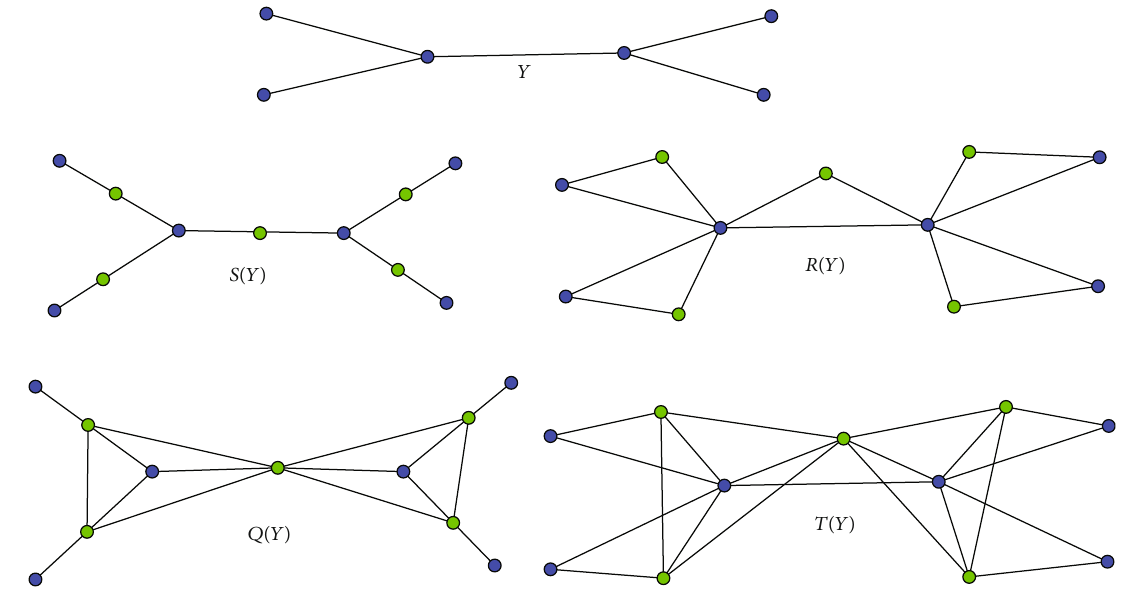
Figure 1: The graph Y and its S ð Y Þ , R ð Y Þ , Q ð Y Þ and T ð Y Þ .